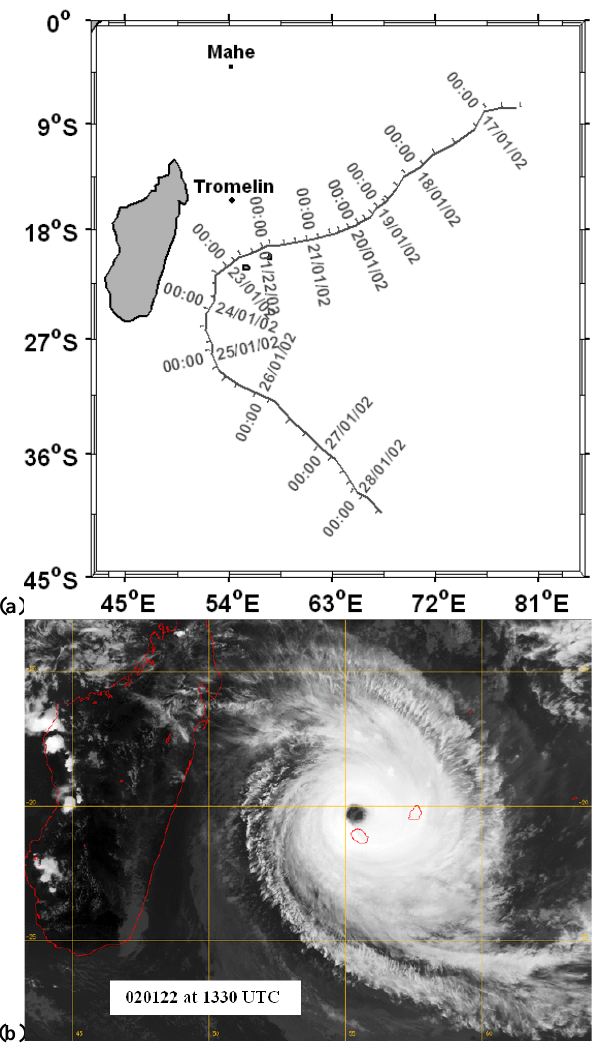
Fig. 1. (a) Best track of tropical cyclone Dina from 17 to 26 Jan- uary 2002 and (b) M´et´eoSat 5 infrared image of TC Dina at closest distance of La Reunion on 22 January at 13:30UTC. (RSMC La